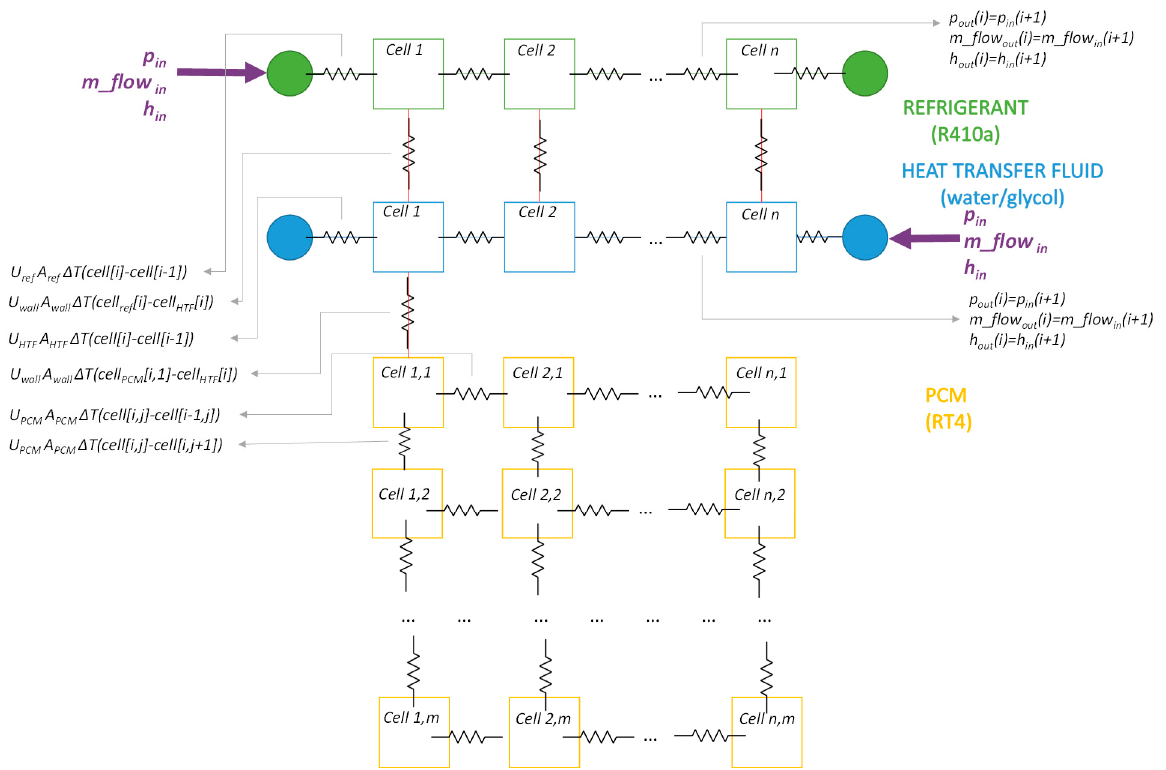
Figure 2. Schematic layout of the lumped model of the three-fluids heat exchanger with latent thermal storage. Initial and Boundary